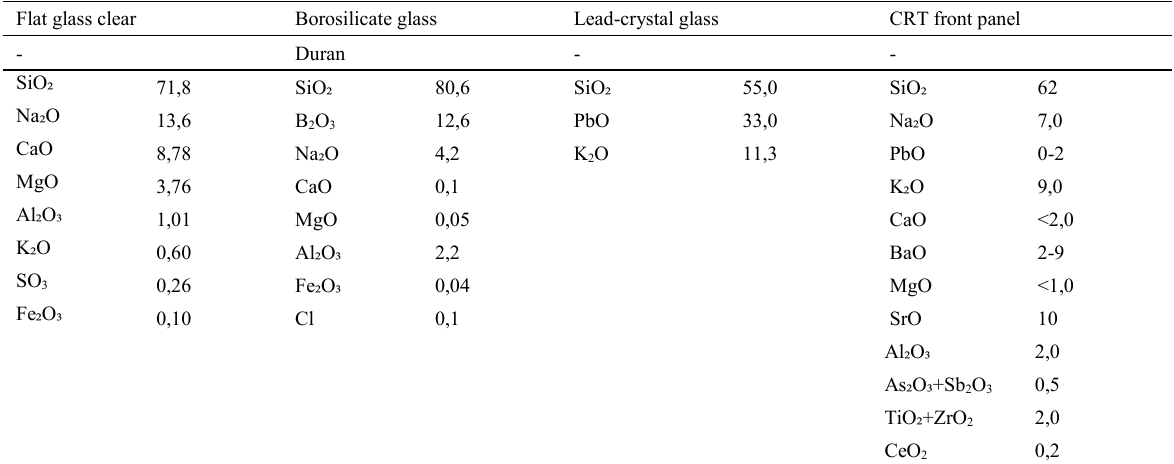
Table 2: Different types of glass chemical composition in wt% (Glass for Europe 2015; James E. Shelby 2005).